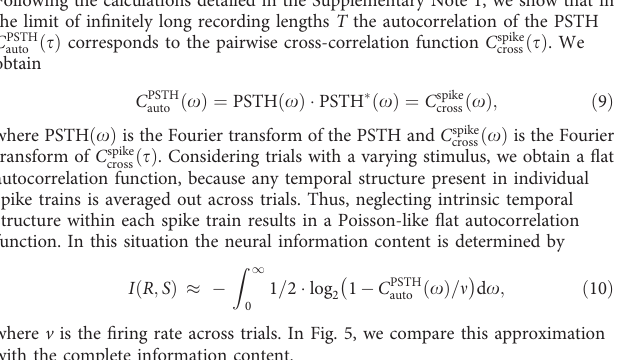
p (cid:4) s ð t Þþ ffiffiffiffiffiffiffiffiffiffiffiffiffiffiffiffiffi 1 (cid:2) SNR (cid:4) n ð t Þ , where